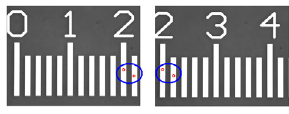
Fig. 4. Points used for the image registration.